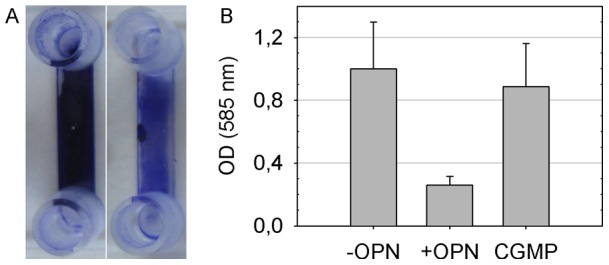
Quantification of biofilm formation by crystal violet staining.Biofilms were grown in flow channels for 30 h on 1/10 diluted THB containing 26.5 µmol/L OPN, 26.5 µmol/L CGMP or none of the two proteins. A. Photograph showing biofilms grown with (right channel) and without OPN (left channel) after crystal violet staining. When OPN was present in the medium, less biofilm formed in the flow channels. B. Quantification of the biofilm biomass by spectrophotometry. OD585 was significantly lower when biofilms were grown in the presence of OPN (+OPN), as compared to biofilms grown on THB only (−OPN). No such effect was observed when CGMP was present in the medium (CGMP). Error bars indicate standard deviations.